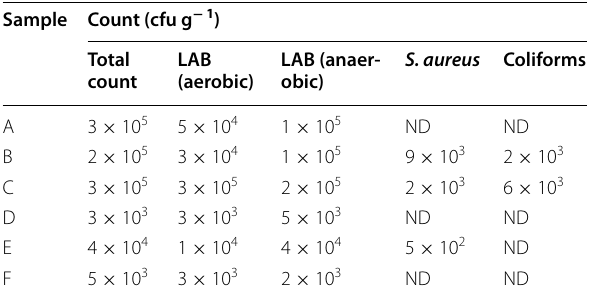
Table 2 Results of microbiological analysis of Motal cheese